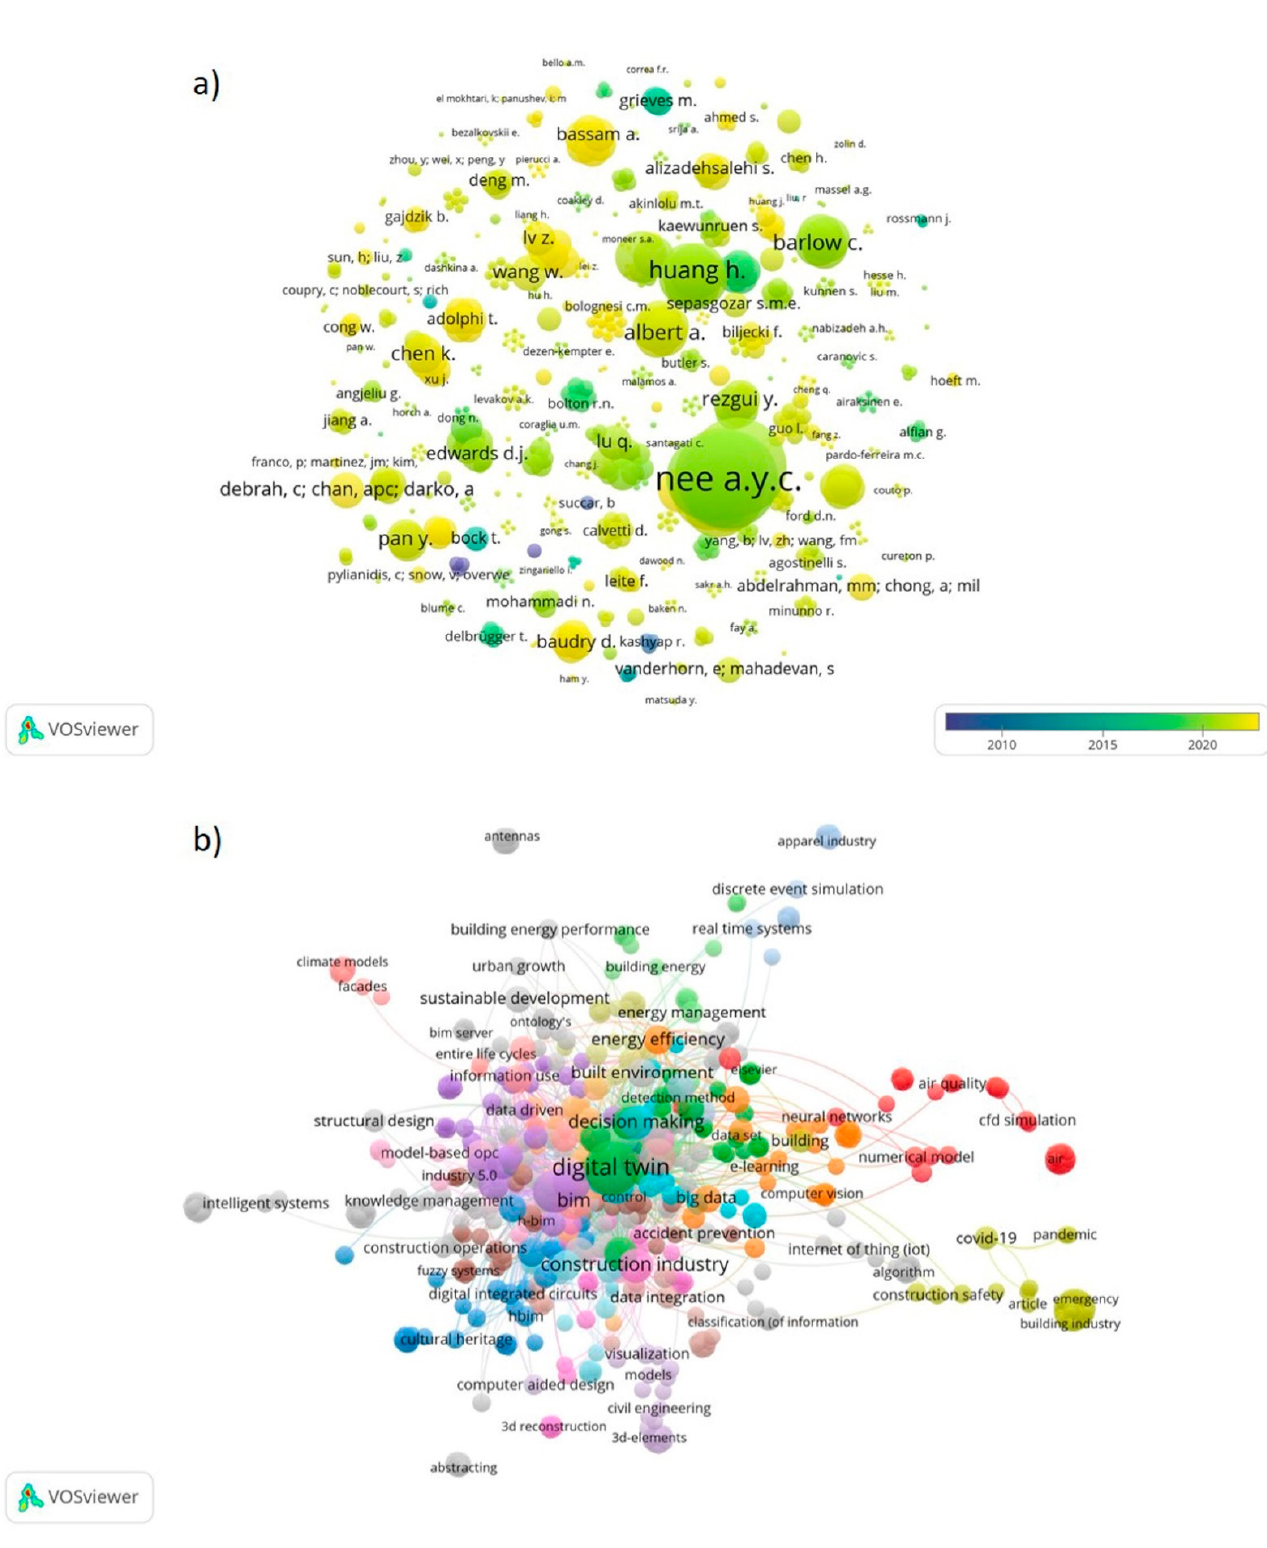
Figure 2. Bibliometric analysis of ( a ) co-authorship, and ( b ) co-occurrence of related studies.